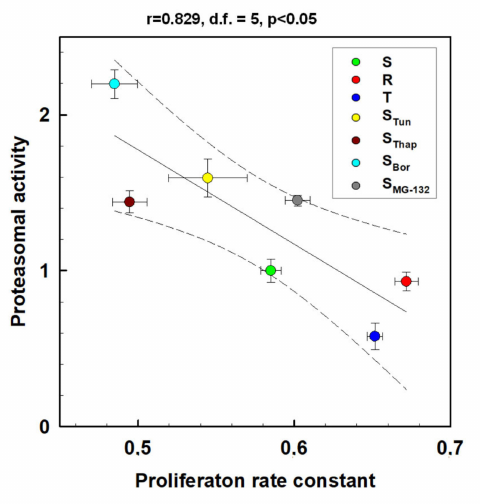
Figure 7. Correlation between proteasomal activity and proliferation rate constants of L1210 cell variants. The data used for the correlation analysis are documented in Figure 6 and Figure S1 (in Supplementary files) and represent value ± S D. The regression line (solid line) was characterized by a 0.95 confidence interval (dashed line). r-correlation coe ffi cient, d.f.-degree of